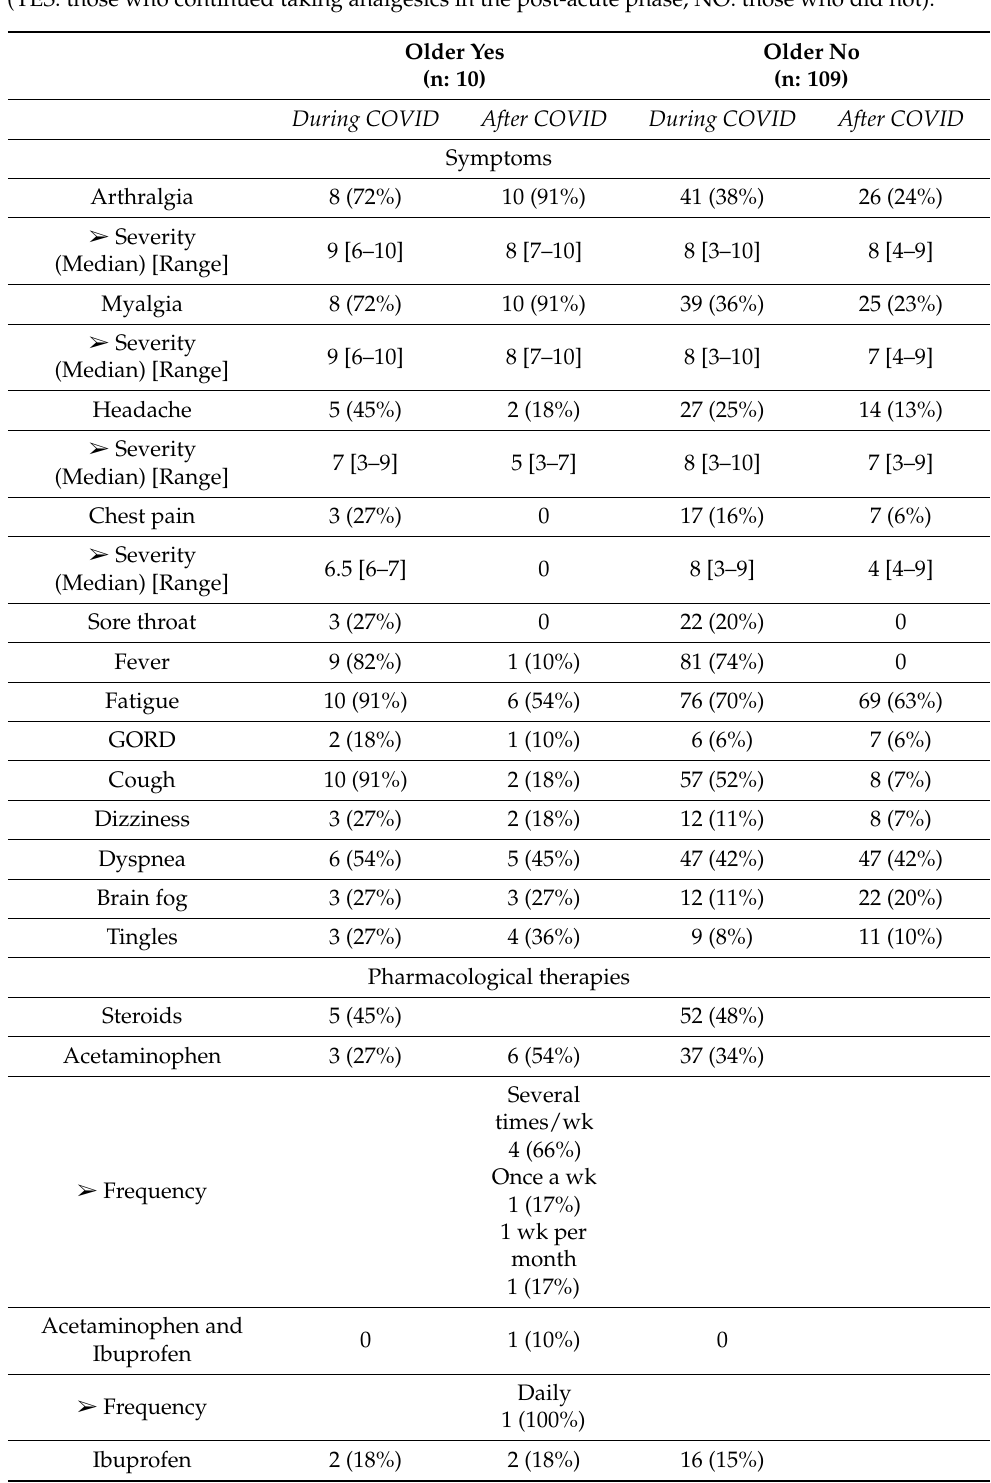
Table 4. Symptoms during and after COVID-19 and utilization of analgesic therapies in older subjects (YES: those who continued taking analgesics in the post-acute phase; NO: those who did